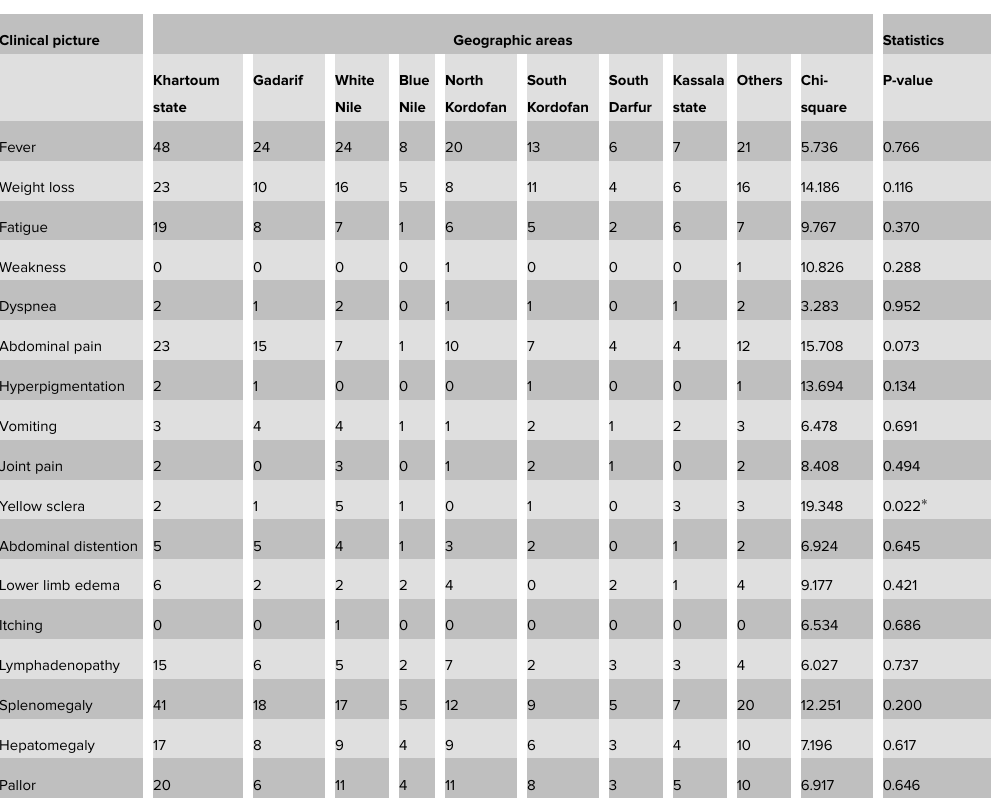
Table 9: Association between clinical presentations of patients diagnosed with VL at the TDTH and geographic